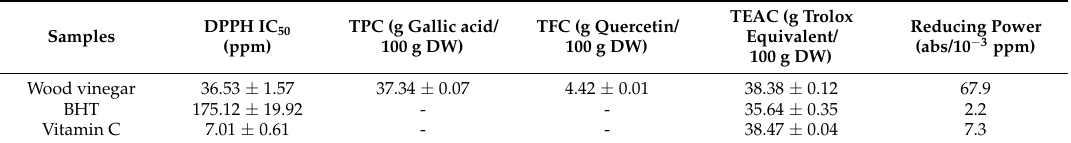
Table 3. Antioxidant activity of the wood vinegar #